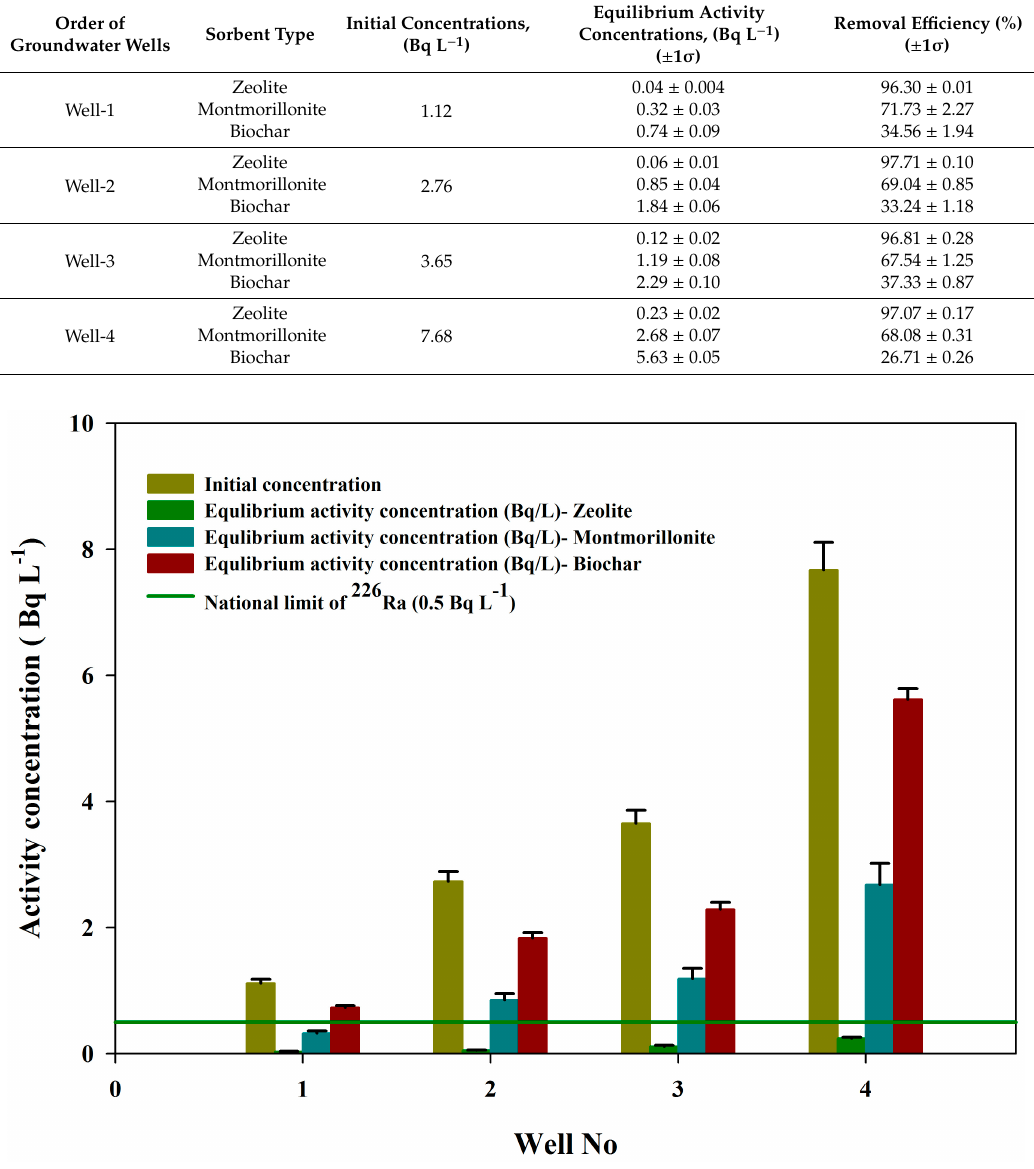
Figure 4. Equilibrium concentrations of 226 Ra in groundwater samples as a ff ected by the three investigated